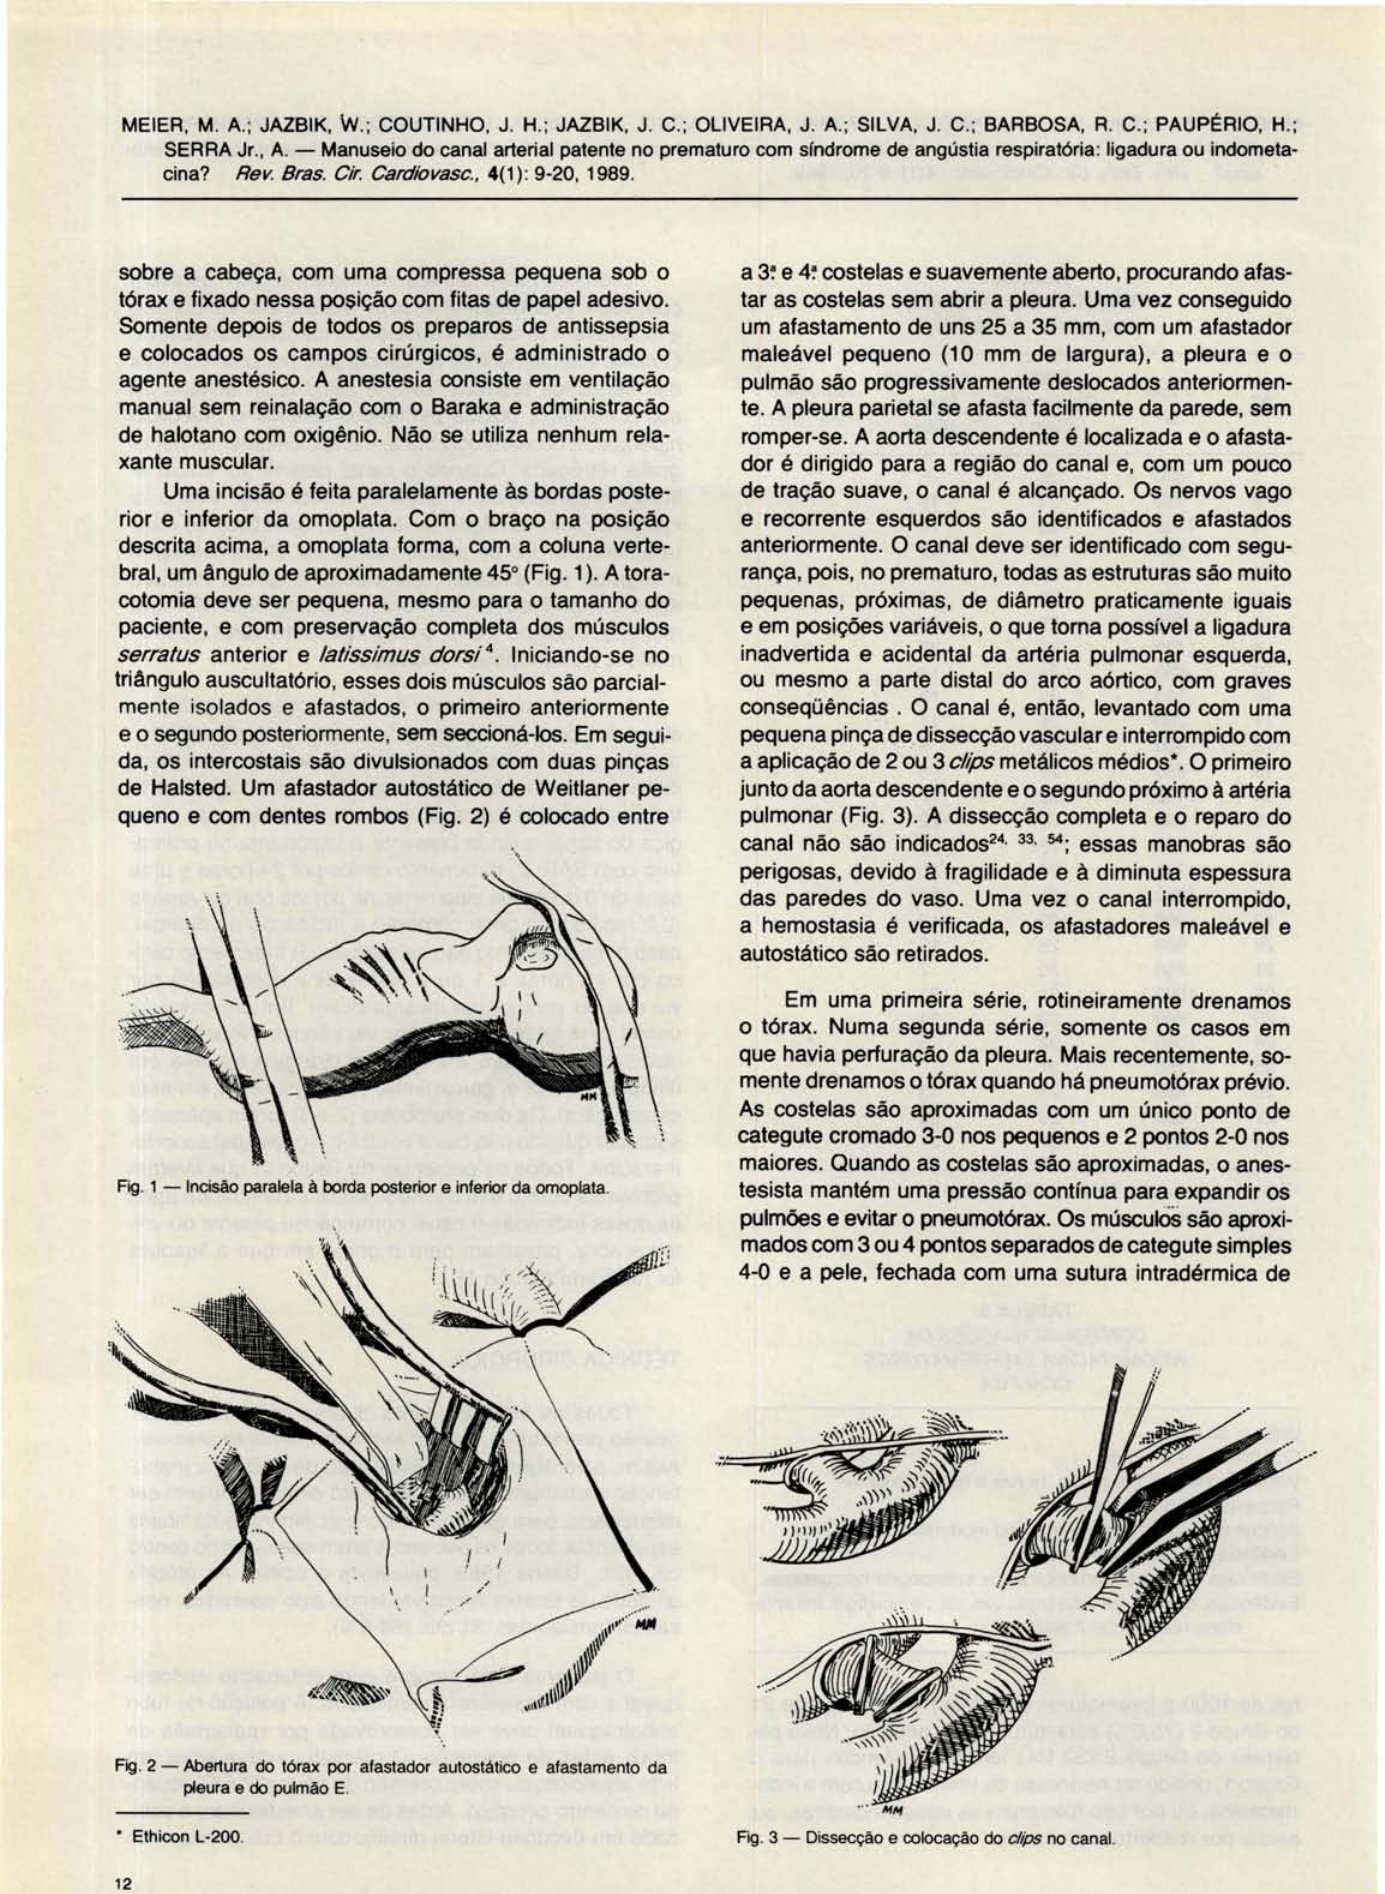
Fig. 2 - Abertura do tórax por afastador autostático e afastamento da pleura e do pulmão E. • Ethicon L-200. Fig. 3 - Dissecção e colocação do c/ips no